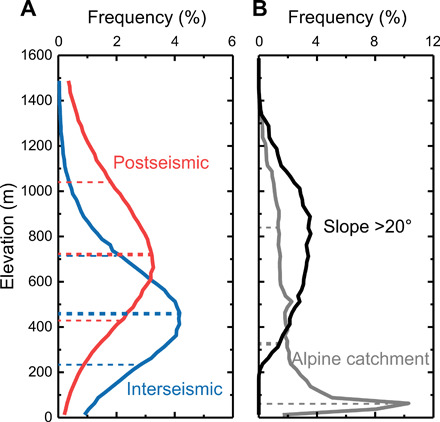
The elevation source of organic matter in Lake Paringa during the inter- and postseismic periods.(A) The blue and red lines show the elevation distributions of eroded soil for the whole record (Fig. 3C) during the inter- and postseismic period, respectively. The dashed lines show the 16th, 50th, and 84th percentiles of the distributions. (B) The gray line shows the elevation distribution of the alpine catchment (the west-flowing catchment of the Windbag River) with 16th, 50th, and 84th percentiles of the distribution as dashed lines. The black line is the distribution of slopes larger than 20° at alpine catchment. The frequency data of (A) and (B) have been binned in 25-m vertical intervals.